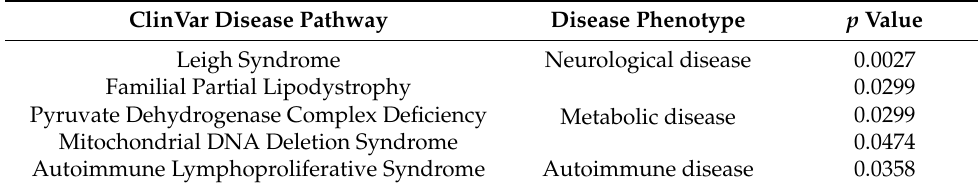
Table 3. ClinVar disease pathways that are significantly enriched in the 121 differentially expressed proteins that are also implicated in both transcriptomic and DNAm